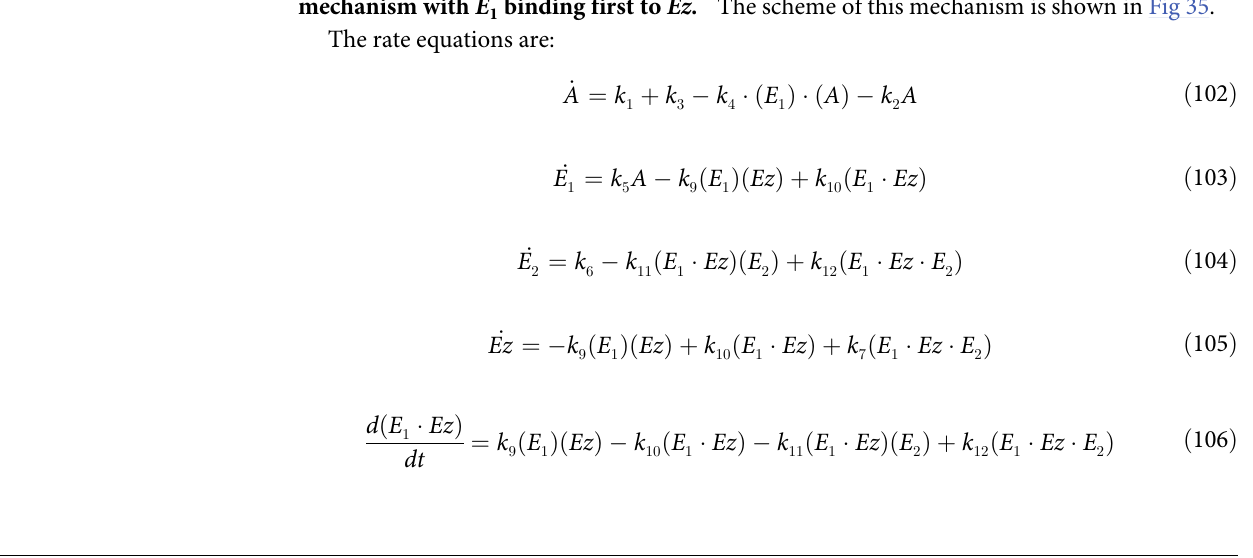
and E by a compulsory-order ternary-complex 1 2